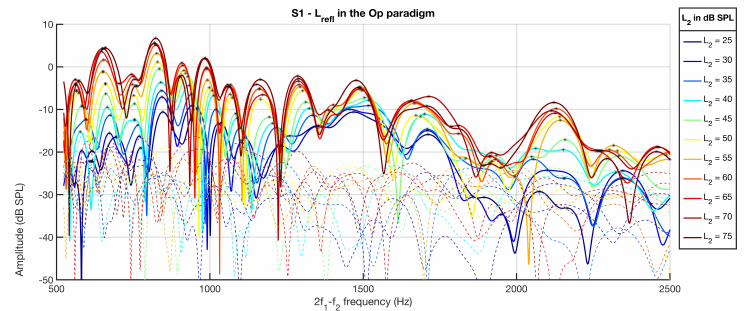
Figure 10. L refl across L 2 s shown in different colors; the stars indicate the location of